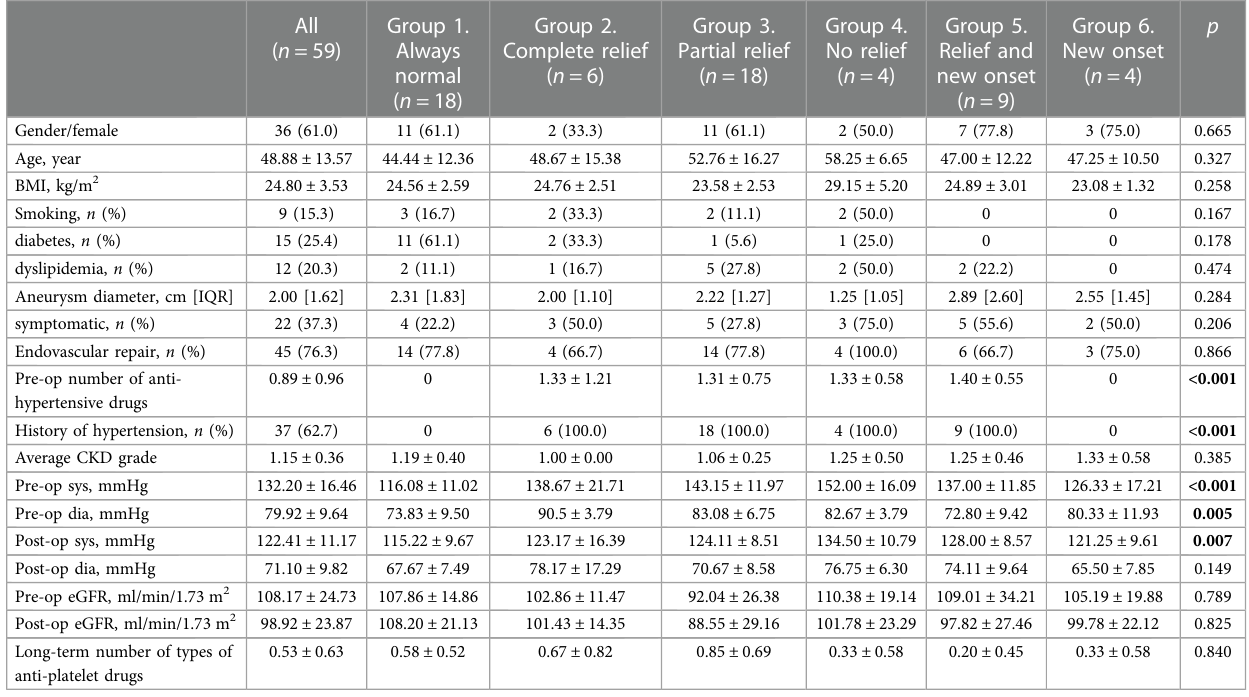
TABLE 1 Disease parameters in all patients and comparison among different hypertension